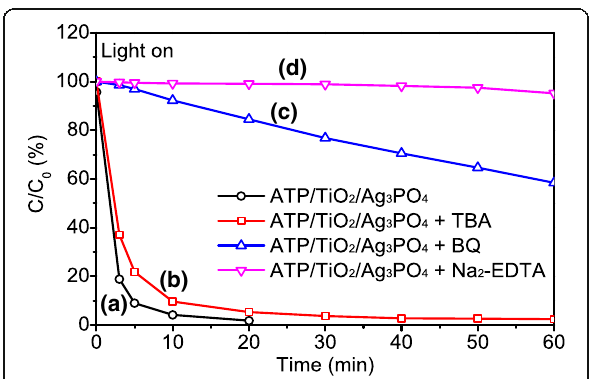
Fig. 6 Reactive species trapping experiments of ATP/TiO 2 /Ag 3 PO 4 composite